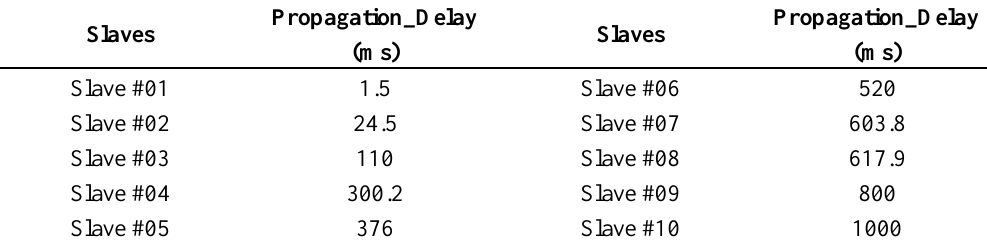
Table 2. Sample of Slave's Propagation_Delays.